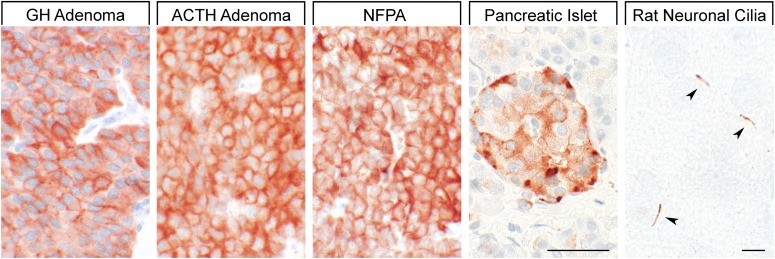
SST3 expression pattern in human pituitary adenomas, human pancreatic islets, and rat neuronal cilia. Immunohistochemistry (red-brown color), counterstaining with hematoxylin; primary antibody: UMB-5; scale bar, 50 µm. SST3 displays both membranous and cytoplasmic expression. NFPA, clinically nonfunctioning pituitary adenoma.